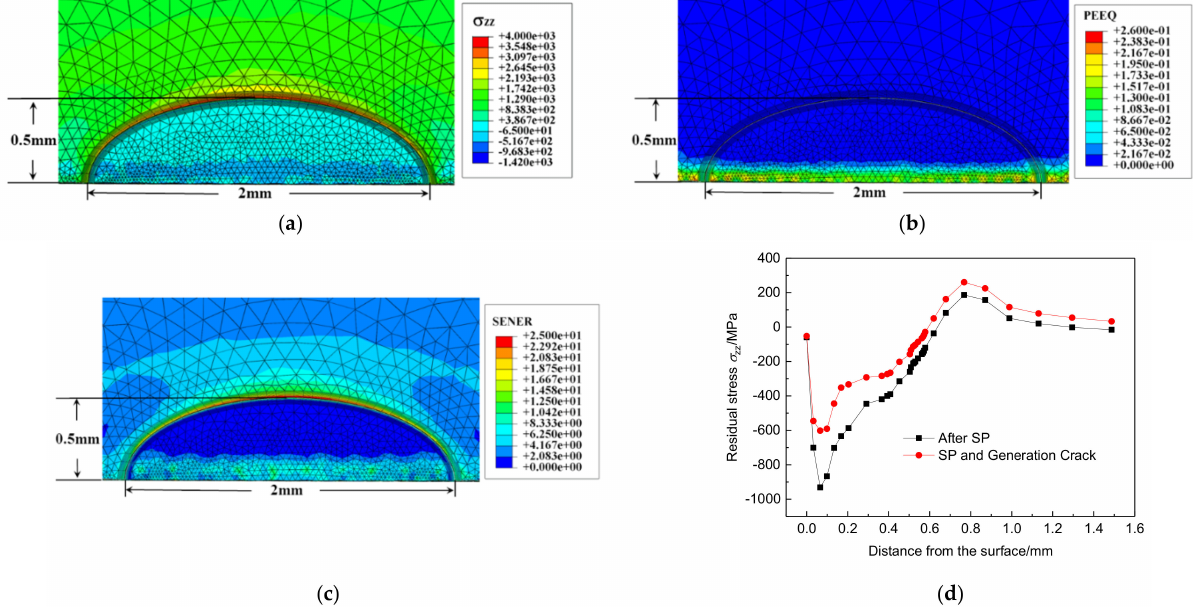
Figure 3. Parameters on the crack face after shot peening and the generation of a 0.5 mm-deep crack. ( a ) Residual stresses perpendicular to the crack plane. ( b ) Equivalent plastic strain. ( c ) Elastic strain energy density. ( d ) Distribution of residual stresses σ zz in the symmetry axis on the symmetry plane of the